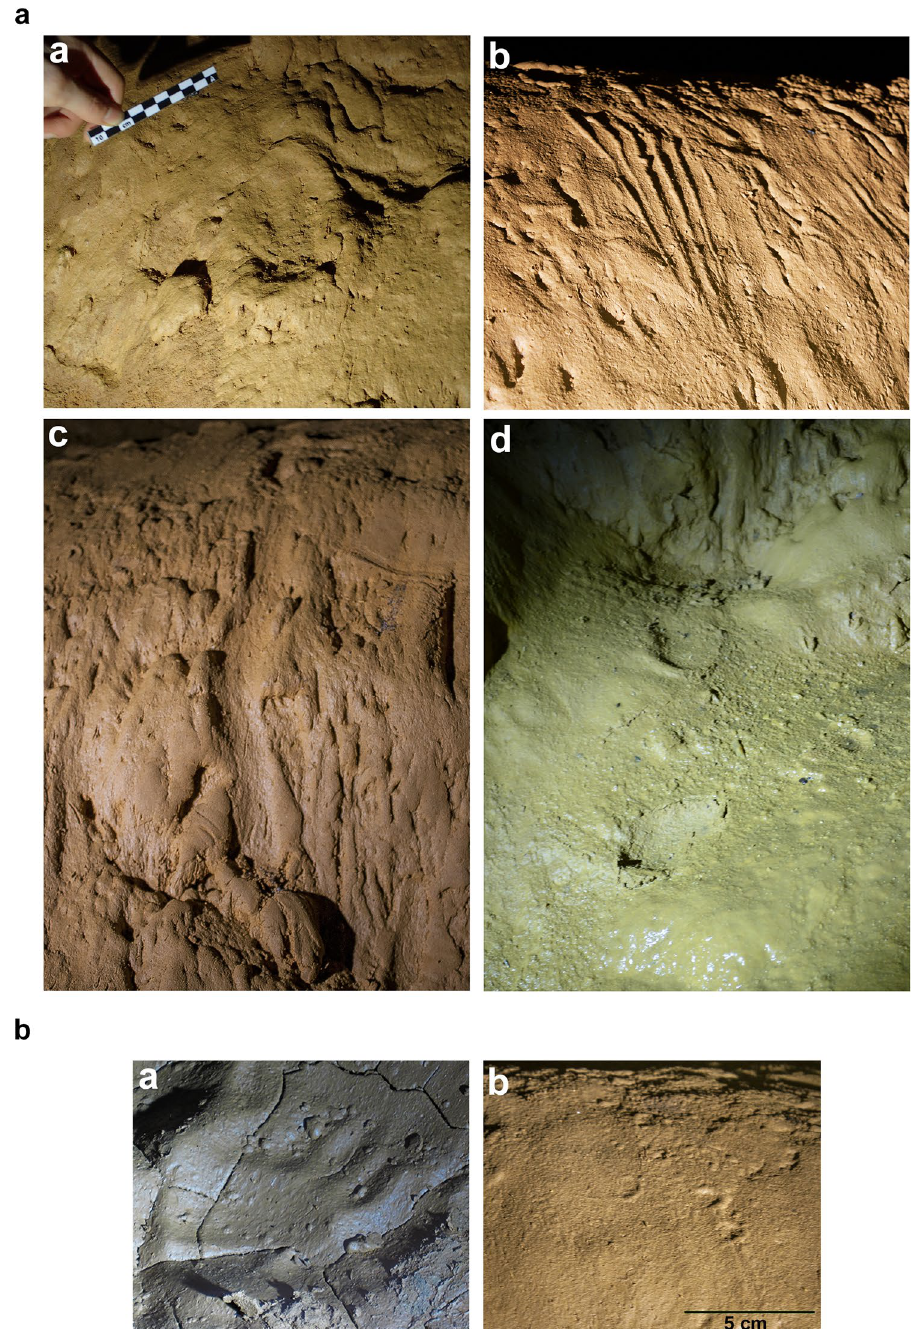
Figure 2. ( a ) Examples of the tracks found in Cussac Cave. ( a ) Human palm print; ( b ) indeterminate print (fingerprints?) (F. Maksud, PCR Cussac, Ministère de la Culture, France); ( c ) slipped heel print; ( d ) two heel prints belonging to a trackway. (N. Fourment, PCR Cussac, Ministère de la Culture, France). ( b ) Digit details. ( a ) Manus bear track located in the same area as T166. ( a ) Human fingerprints located under the Ibex Panel (F. Maksud, PCR Cussac, Ministère de la Culture, France